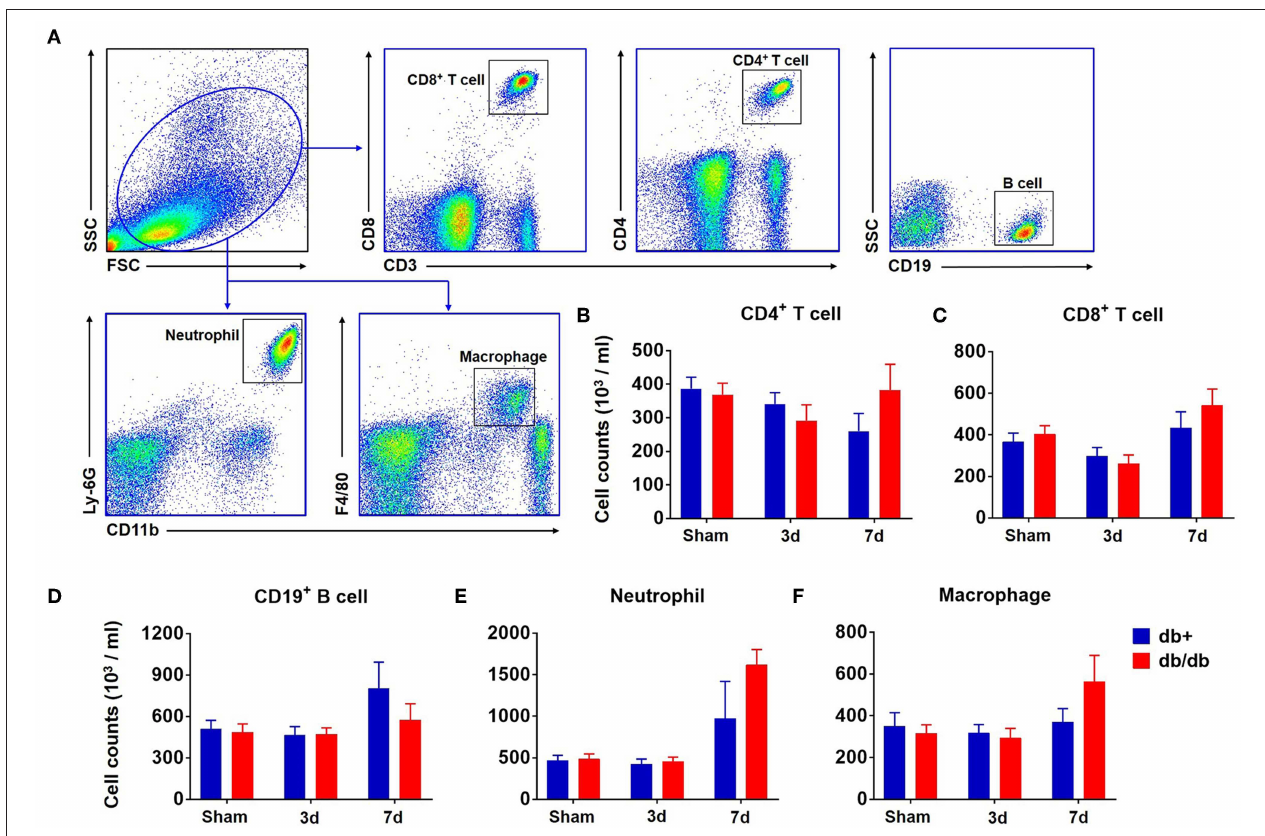
FIGURE 3 | Counts of circulating leucocytes in db/db and db/ + mice following brain ischemia. Groups of db/db and db/ + mice were subjected to sham or dMCAO surgery. The counts of circulating leucocyte subsets were measured by flow cytometry in indicated groups of mice. (A) Gating strategy of macrophages (CD11b + F4/80 + , M ϕ ), neutrophils (CD11b + Ly-6G + ), CD4 + T (CD3 + CD4 + ), CD8 + T (CD3 + CD8 + ), and B (CD19 + ) cells in the blood at day 3 and 7 after dMCAO. (B) Numbers of CD4 + T cells (CD3 + CD4 + ), (C) CD8 + T cells (CD3 + CD8 + ), (D) CD19 + B cells (CD19 + ), (E) neutrophils (CD11b + Ly-6G + ), or (F) macrophages (CD11b + F4/80 + ) in the blood of indicated groups of mice. Data are expressed as mean ± s.e.m, n = 8 per